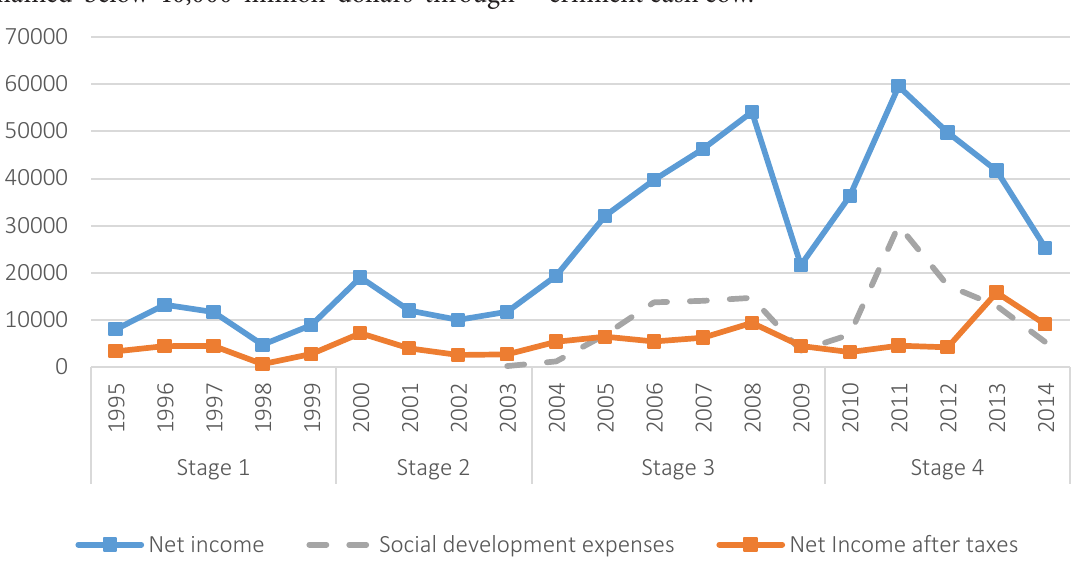
Figure 1. Evolution of company’s profit and social development spending (in millions of USD